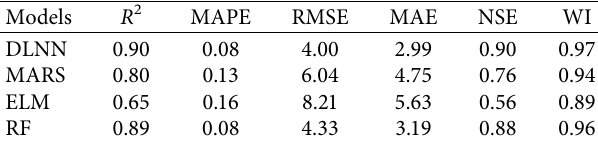
Table 3: The statistical measurements for the developed AI model over the training phase for 70-30% data division scenario.